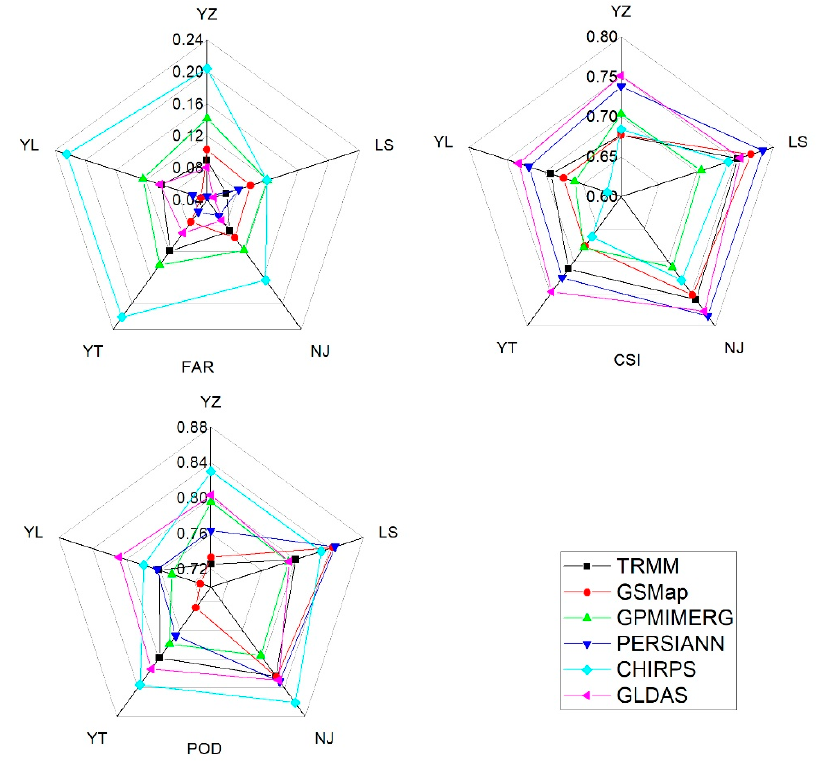
Figure 4. Classification analysis at the basin scale.